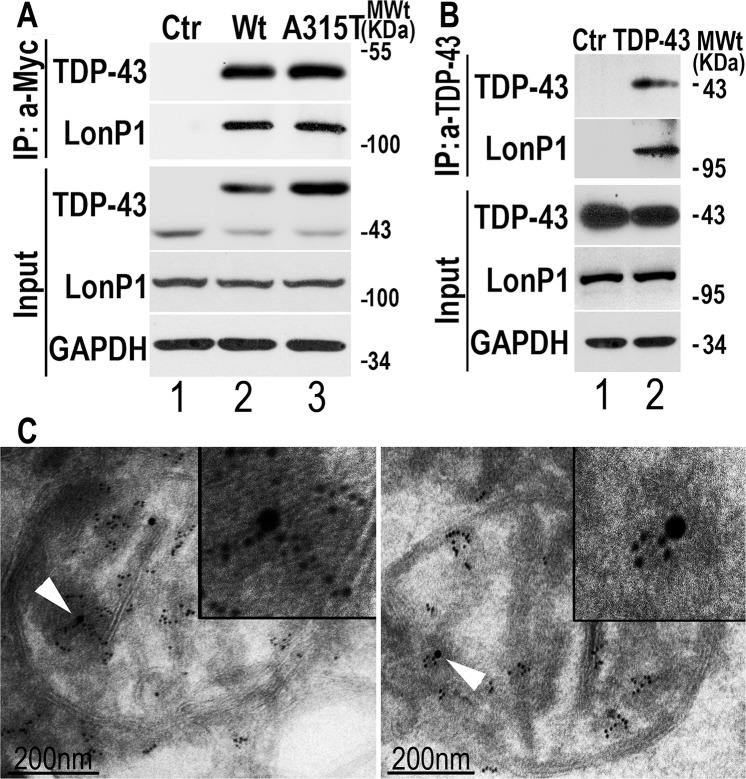
TDP-43 interacts with LonP1.(A, B) Interaction of TDP-43 with LonP1 as detected by co-immunoprecipitation (coIP) assay. (A) Immunoprecipitation experiment was performed using a monoclonal anti-Myc antibody with cell lysates from HEK293 stable inducible cells expressing vector control (Ctr) or Myc-tagged Wt or A315T-mutant TDP-43 (36 hr following Tet-induction). Western blotting experiments were carried out using specific anti-LonP1 or TDP-43 or Myc antibodies as indicated in cell lysates or immunoprecipitated proteins. (B) The endogenous TDP-43 protein interacts with LonP1. Immunoprecipitation experiment was performed with HEK293 cell lysates using the specific anti-TDP-43 antibody or non-specific IgG as a control (Ctr). LonP1 was detected by WB in immunoprecipitated proteins by anti-TDP-43, but not in that by the IgG control. Data in panels A and B represent three independent experiments. (C) IEM analyses reveal co-localization of TDP-43 and LonP1 immunostaining signals inside mitochondria. IEM was carried out to examine mitochondria in brain tissue of FTLD-TDP patients using murine anti-TDP-43 and rabbit anti-LonP1 followed by anti-murine- 6nm gold particles and anti-rabbit-15nm gold particles.